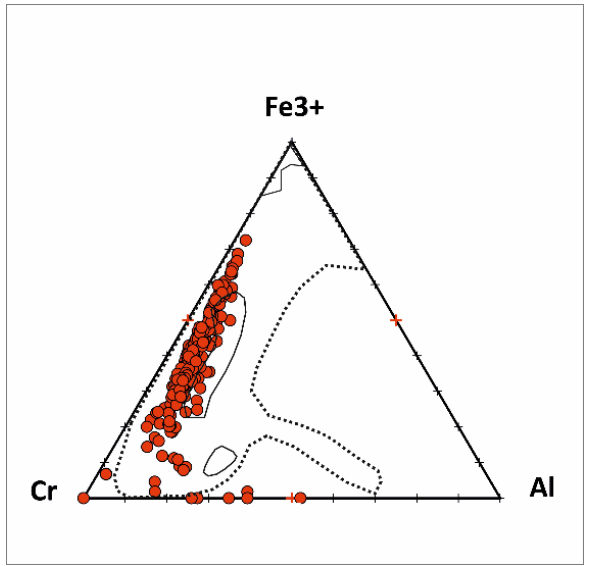
Figure 5. Cr-Fe 3+ -Al ternary diagram for the spinels and alkaline basalts studied here; lamprophyres, related rocks [11] (dotted line), and Alaskan ultramafic complexes [11] (continuous line).